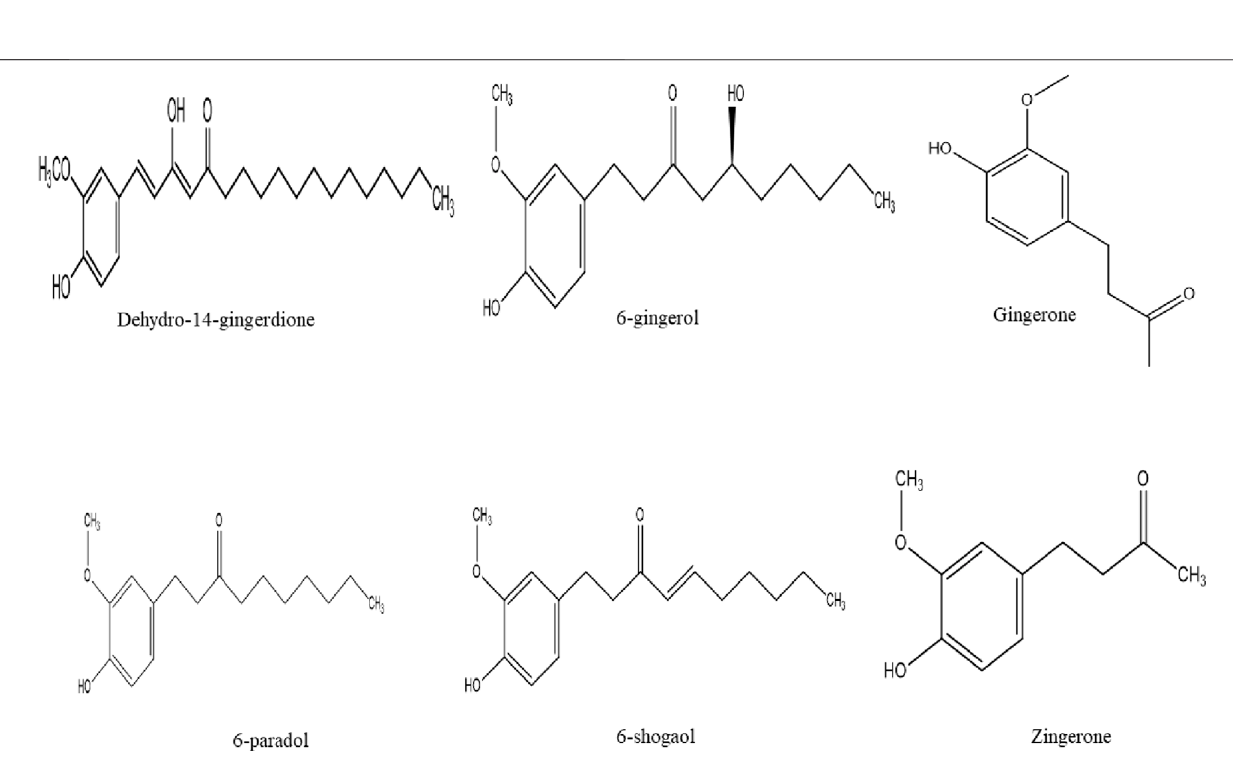
Frontiers in Pharmacology |